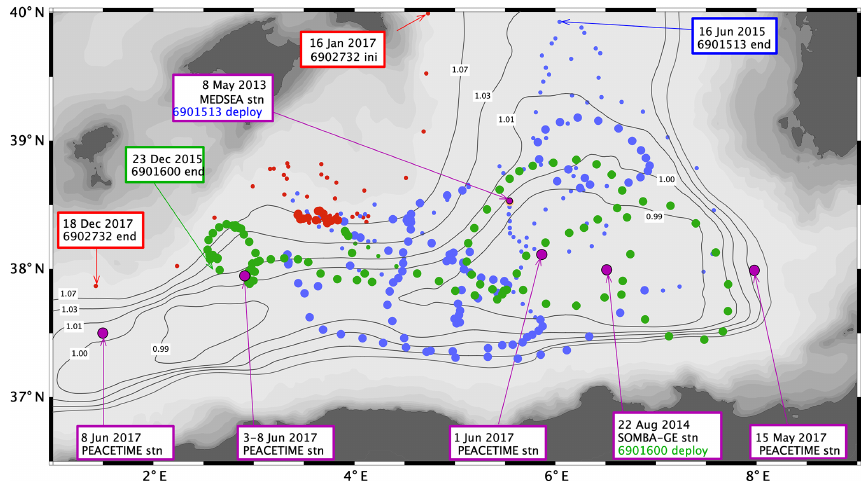
Figure 6. Locations of the CTD profiles in the Algerian Basin. The large dots mark the positions where staircases were detected. Float 6901513 deployment is indicated in blue, 6901600 in green and 6902732 in red. Shipboard stations during float deployments and the cruise PEACETIME are indicated in purple. Thin black lines: contours f/H normalized by f o at 37 ◦ 45 (cid:48) N and H o = 2800m.